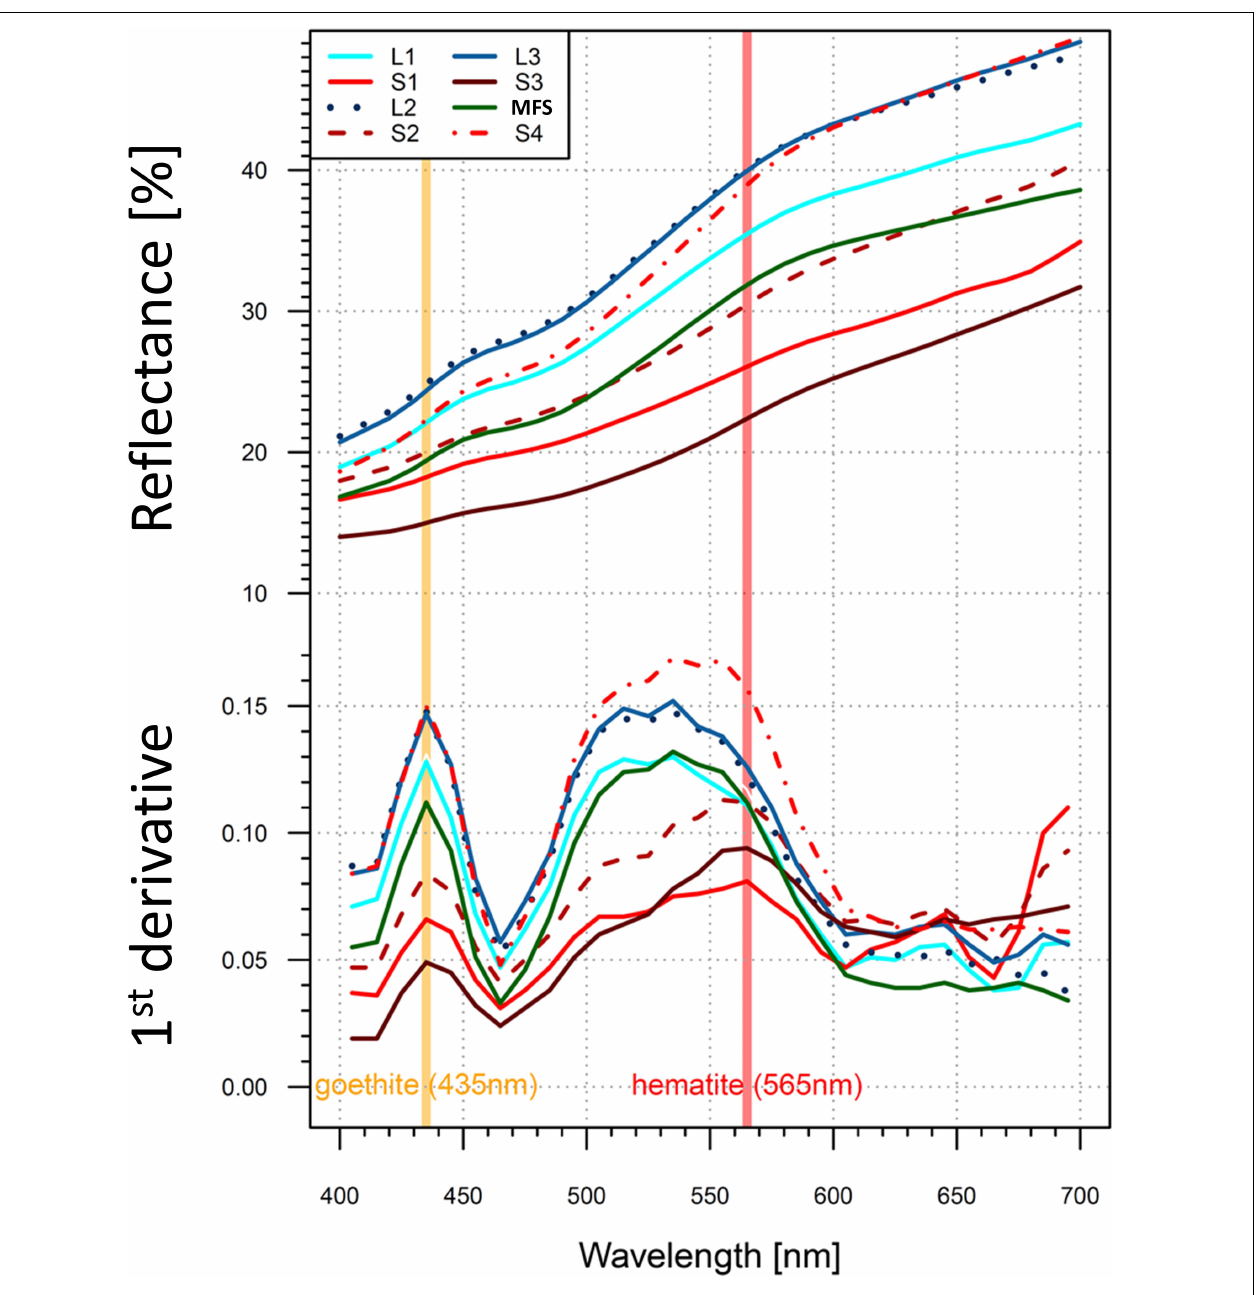
FIGURE 2 | DRS analysis of selected representative samples from different stratigraphical units of the Zemun LPS. Upper plot displays raw backscattered intensities of wavelengths ranging between 400 and 700 nm in 10 nm intervals. Lower plot displays the first derivatives of backscattered wavelengths. Assumed contributions of hematite and goethite at distinct wavelengths are indicated as orange and red vertical bands, respectively. MFS is the abbreviation for marshy floodplain